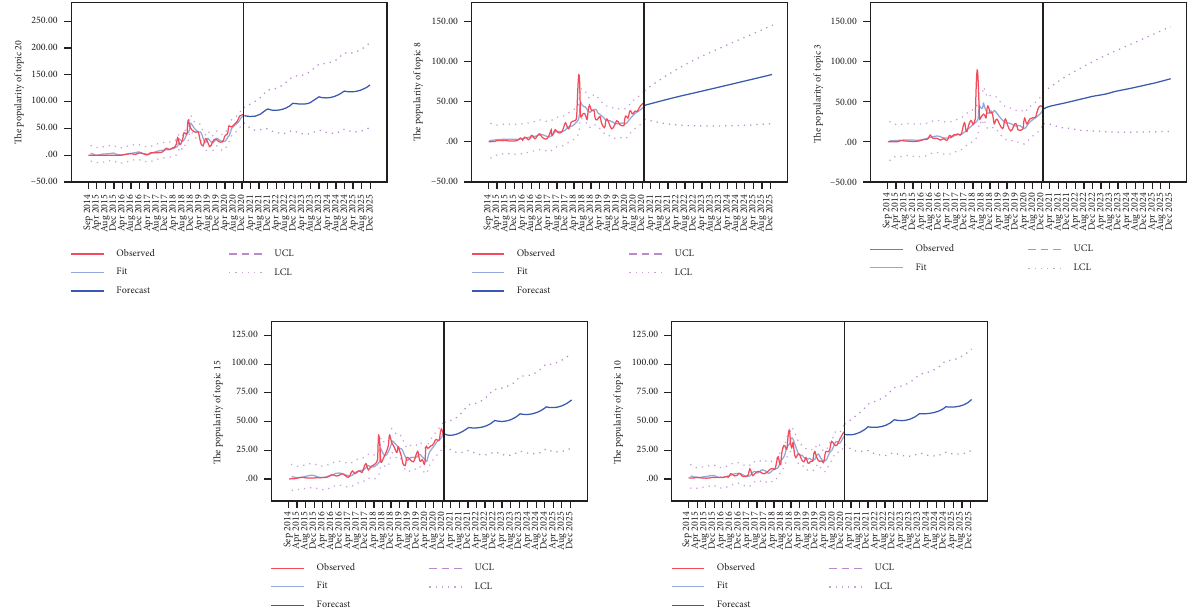
Figure 14: Forecast results of the development trend of new energy vehicle technology topics in